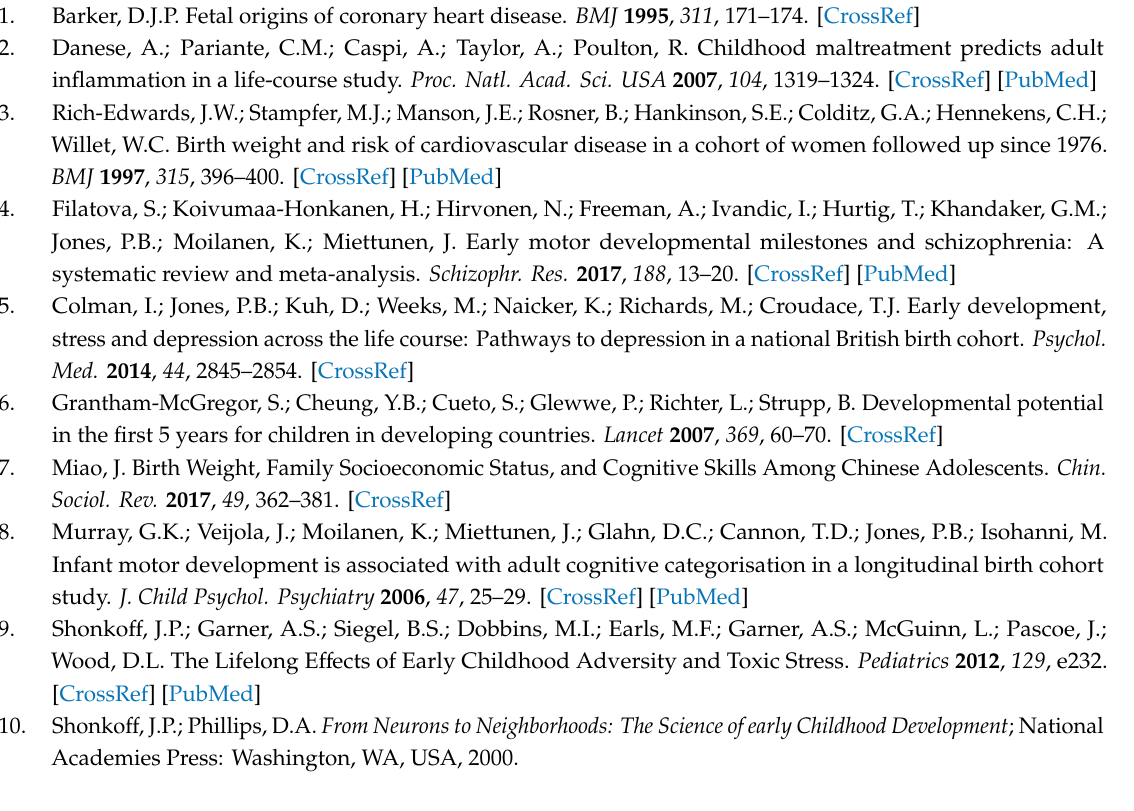
Figure A3. Predicted age of attainment of development milestones with maternal education as a function of county-level GDP per capita for children under age of 5.